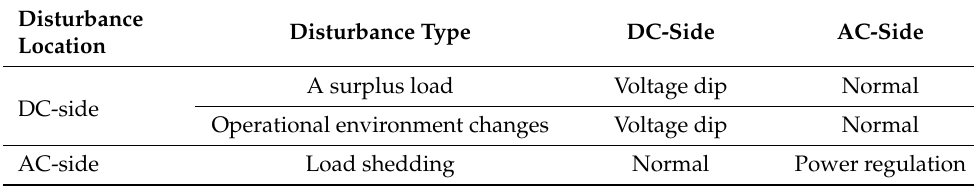
Table 4. Effects of disturbance on hybrid microgrid.